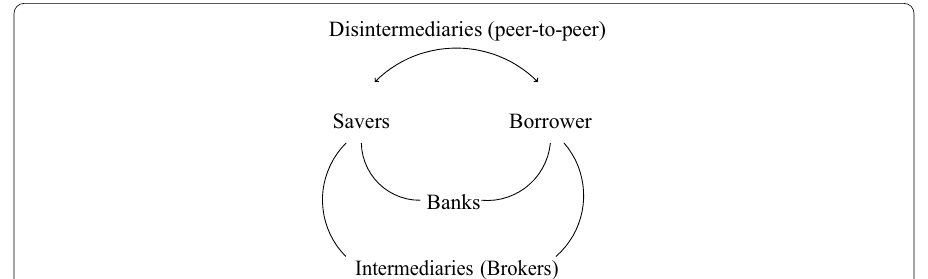
Fig. 1 How banks act as intermediaries between lenders and borrowers. This function call also be conducted by intermediaries as brokers, for example by shadow banks. Disintermediation occurs over the internet where peer-to-peer lenders match savers to